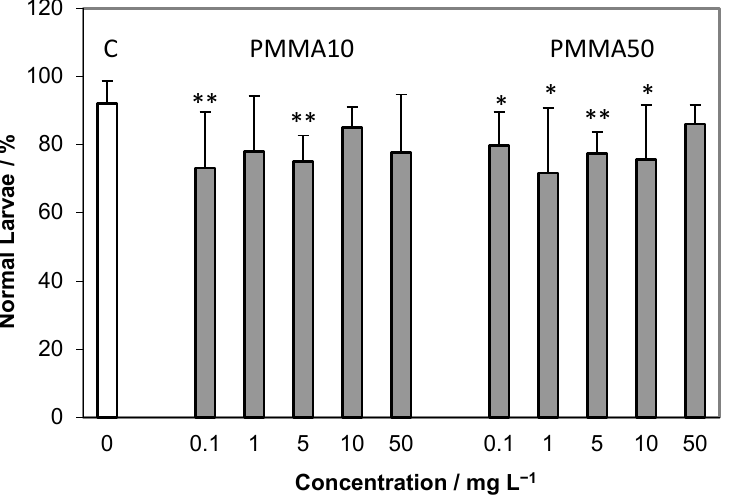
Figure 3. Percentage (mean ± SD) of normally developed plutei larvae after 72 h exposure to various concentrations of 10 and 50 µ m PMMA microparticles (C—control). * p < 0.05, ** p < 0.01.